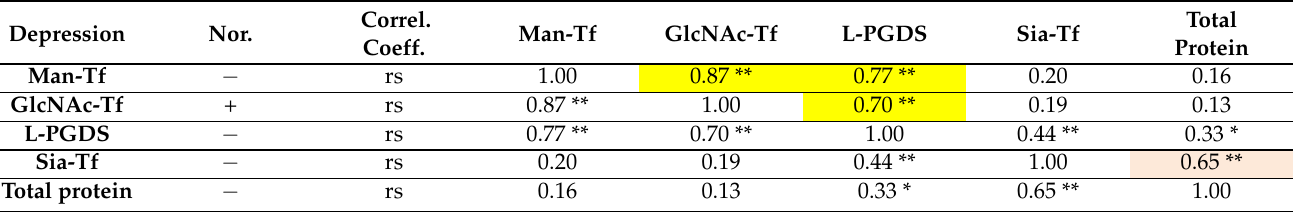
Figure 2. Scatter diagrams and regression lines of marker combinations in the CSF of depression patients. Table 1. Correlation coefficients of markers in depression patients.